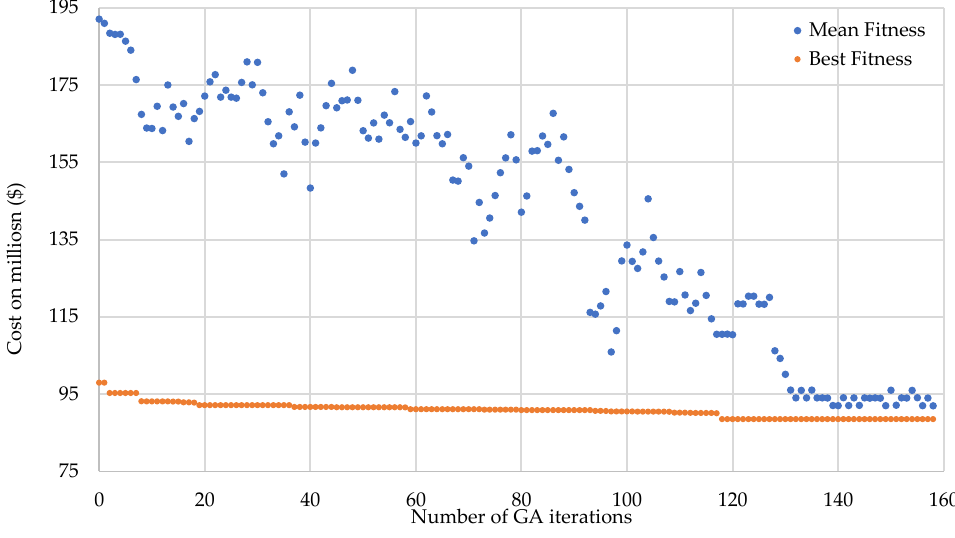
Figure 8. CASE-B genetic algorithm (GA) convergence graph.